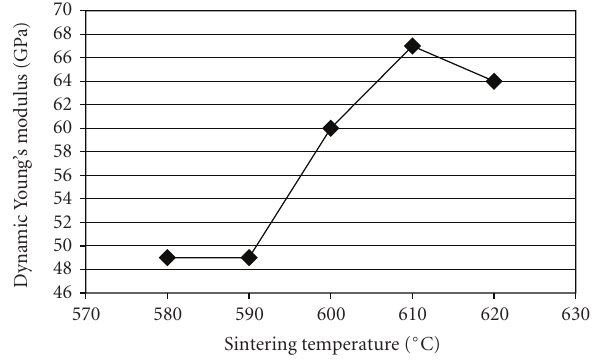
Figure 4: TRS as a function of sintering temperature. Figure 5: DYM as a function of sintering temperature.